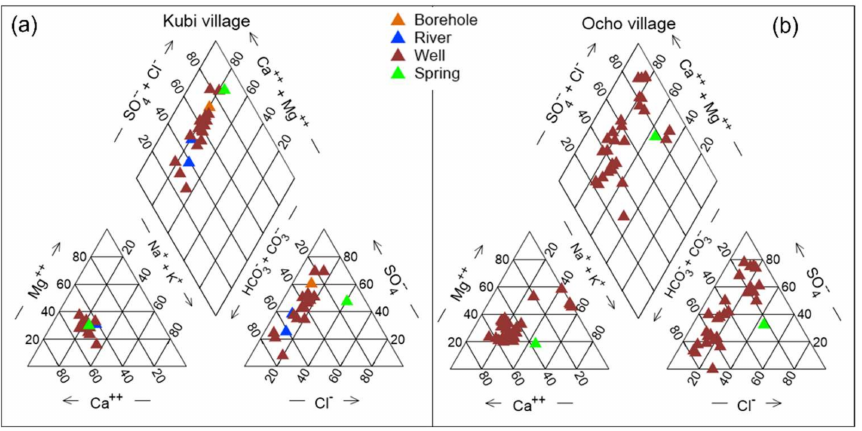
Figure 3. Piper diagram of surface water and groundwater in ( a ) Kubi and ( b ) Ocho (adapted from Piper